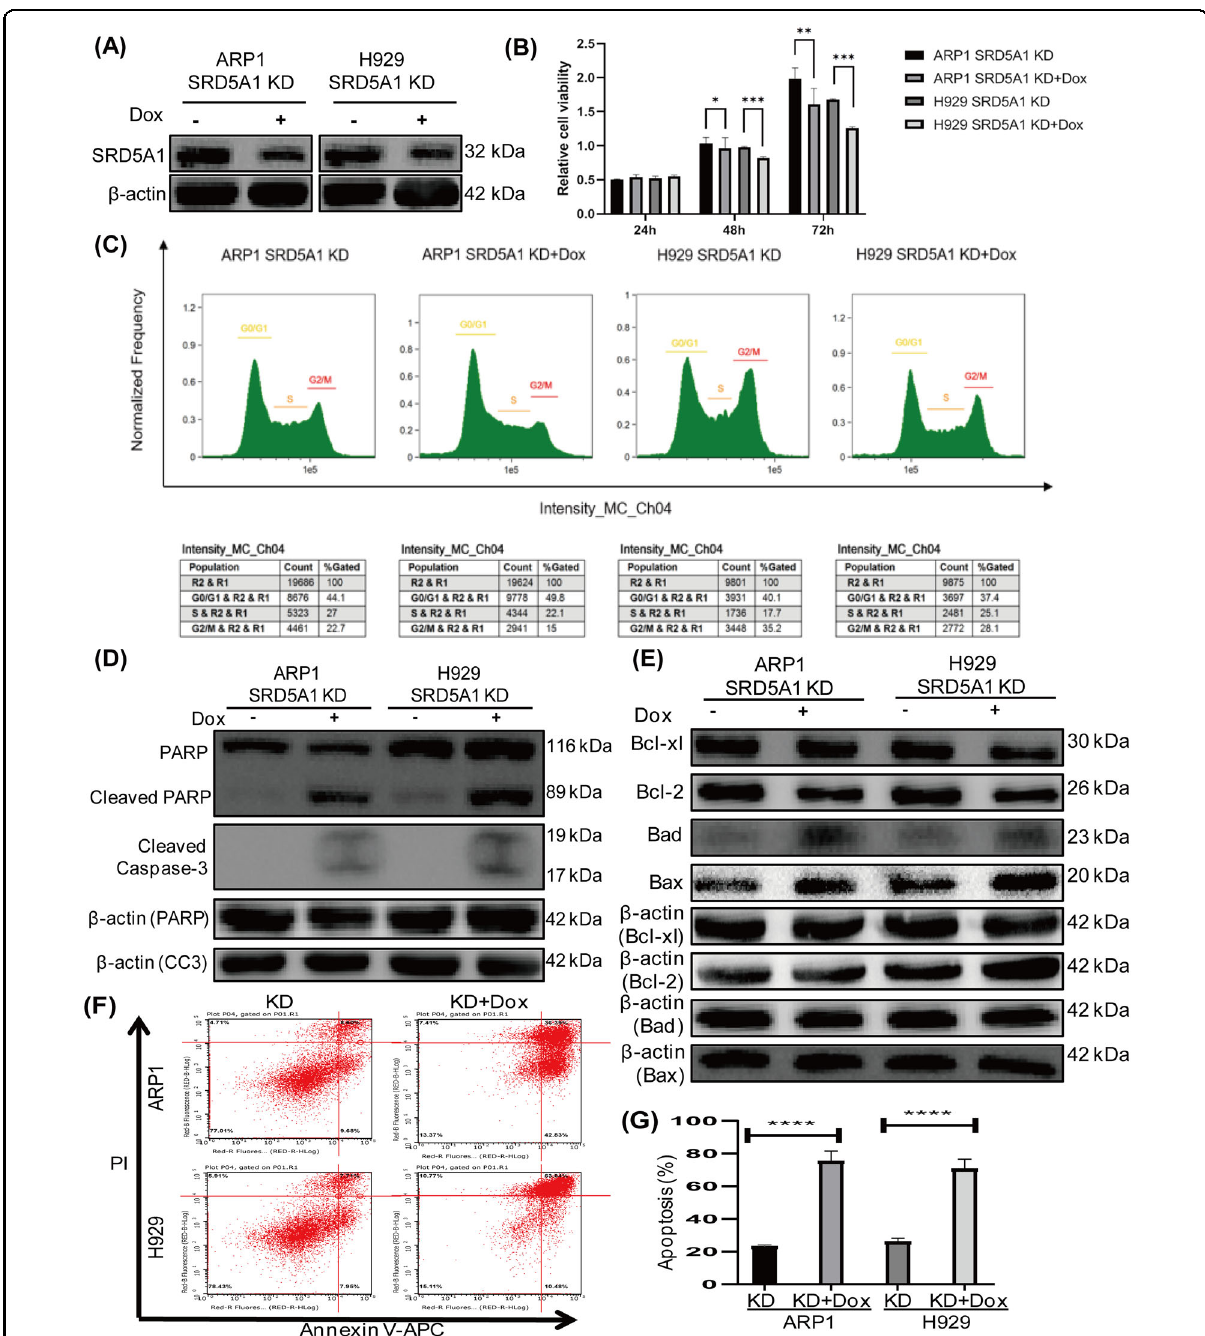
Fig. 2 Inducible downregulation of SRD5A1 in fl uences growth and survival of myeloma cells in vitro. A Western blotting analysis for SRD5A1 expression of ARP1- and H929-SRD5A1-KD cells treated with or without Dox. B Histogram plot depicted the growth of ARP1- and H929-SRD5A1-KD cells treated with or without Dox. C PI-staining cell cycle analysis of ARP1- and H929-SRD5A1-KD cells treated with or without Dox. D Western blotting revealed that SRD5A1 knockdown-induced apoptosis by detecting the expression of PARP and cleaved caspase-3 proteins. E Immunoblot analysis of Bcl-xl, Bcl-2, Bad, and Bax protein levels in ARP1- and H929-SRD5A1-KD cells treated with or without Dox. F Annexin-V/PI staining indicated that more apoptosis cells were induced post downregulation of SRD5A1 in ARP1 and H929 cells. G Quanti fi cation of apoptosis cells rate in ( F